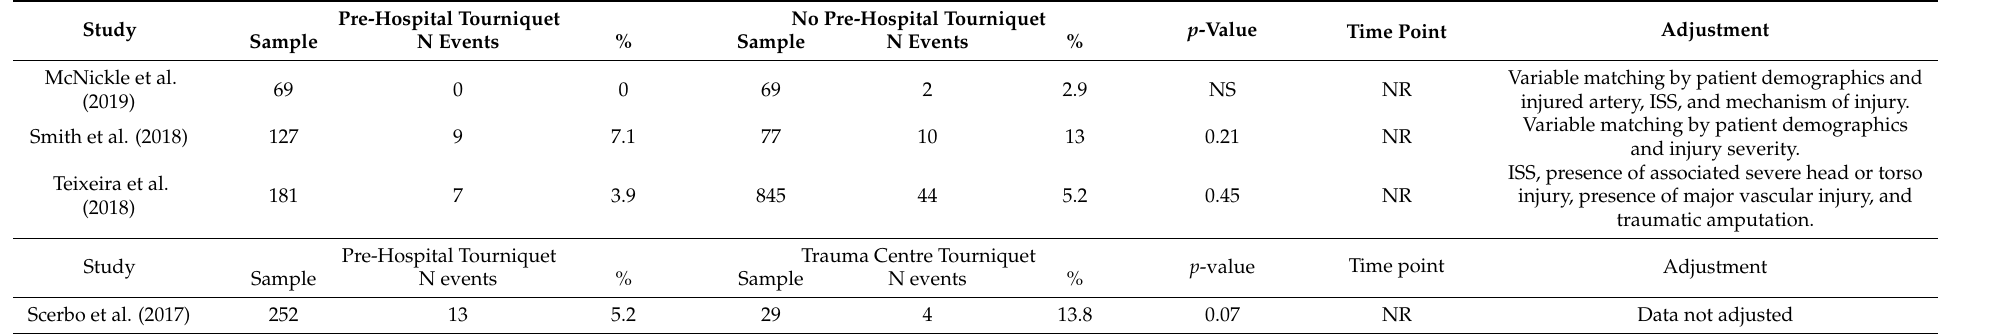
Table 3. Outcome data for the comparisons of